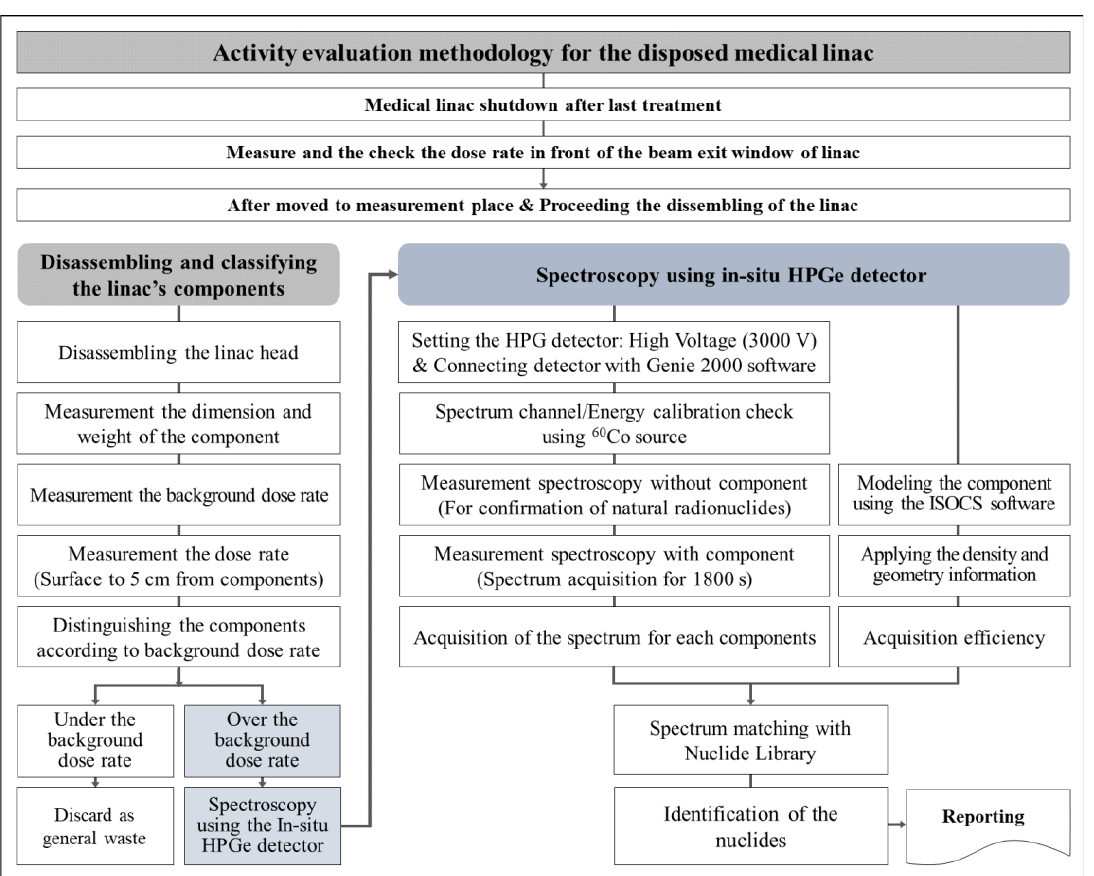
Figure 2. Procedure of the activity evaluation methodology for the disposed medical linac.